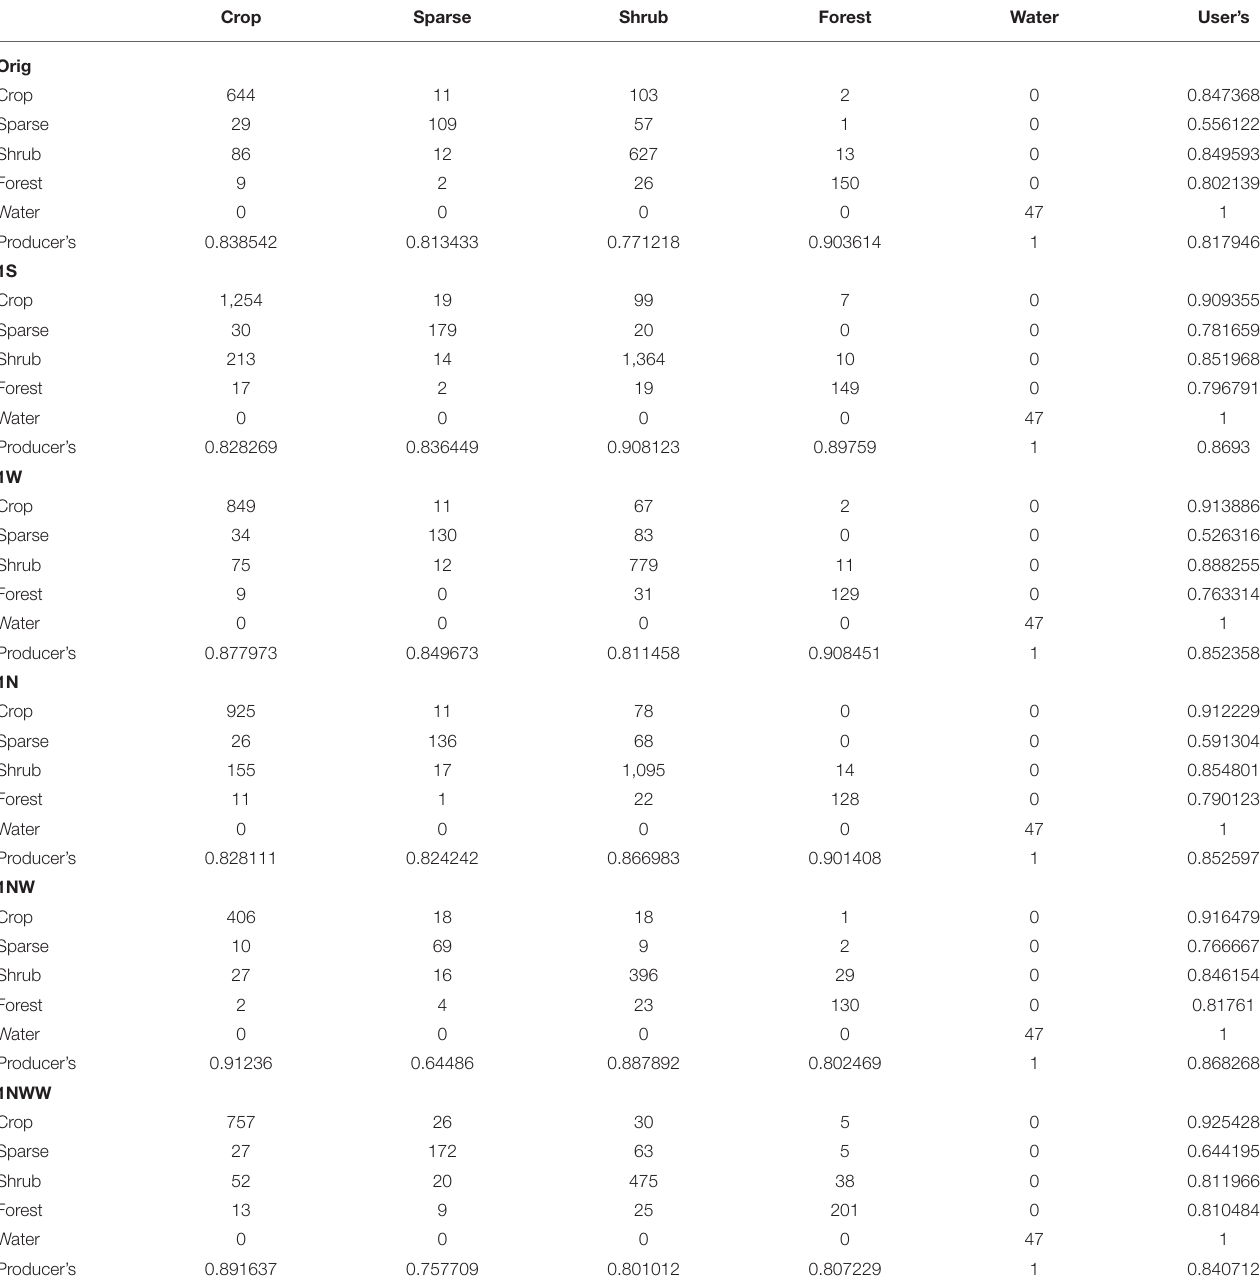
TABLE 3 | Confusion matrices for the primary six tiles, the geographical location of the tiles is shown in Figure 2 . Crop Sparse Shrub